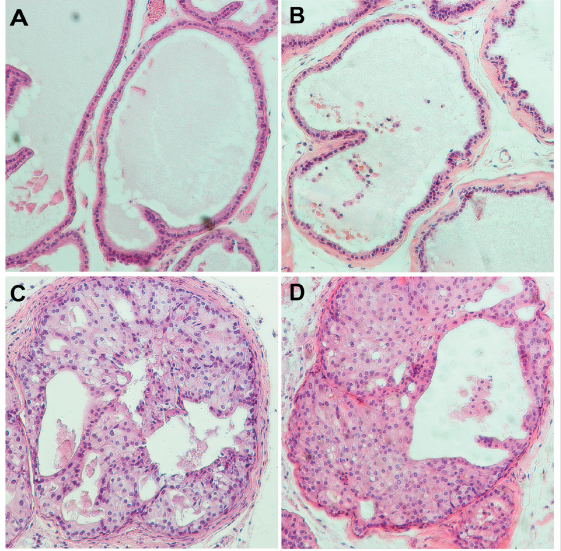
Figure 7. Characterization of PARP7 in a mouse prostate cancer model. Sections of ventral prostates from mice with the four indicated genotypes stained by H&E. Images were captured using a 10 ×